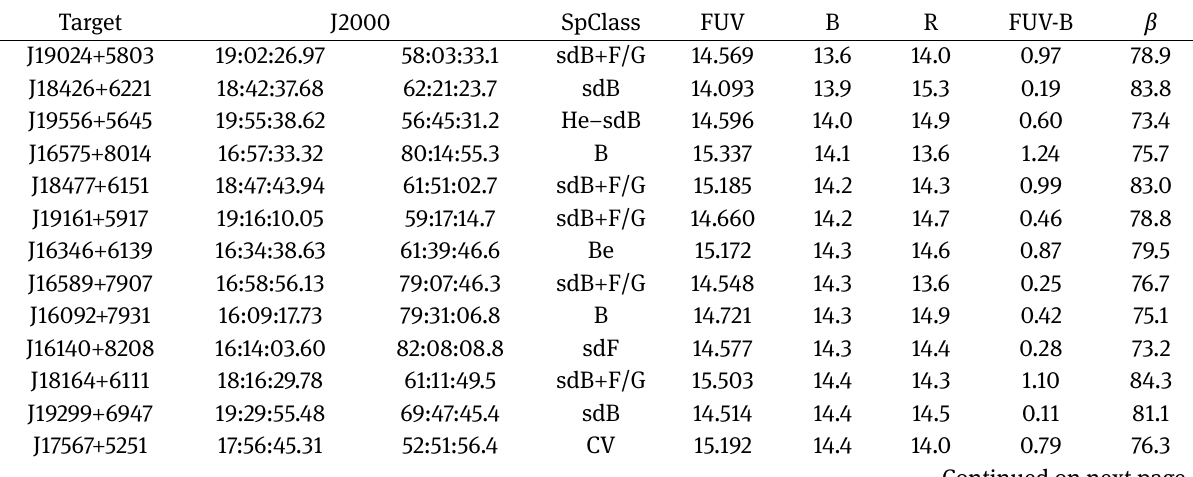
Table 2. Spectral classifications of sdB candidates. Target name, RA (J2000), Dec (J2000), spectral classification, FUV mag , B mag, FUV–B colour, ecliptic